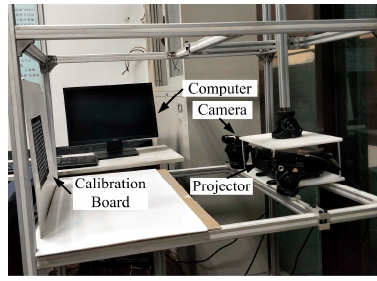
Figure 13. Experimental system.